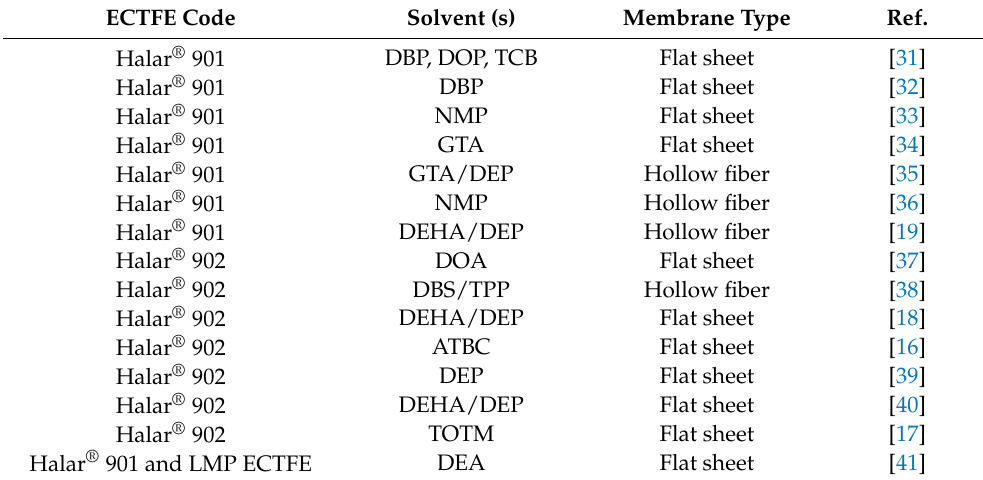
Table 1. The related published work about ECTFE